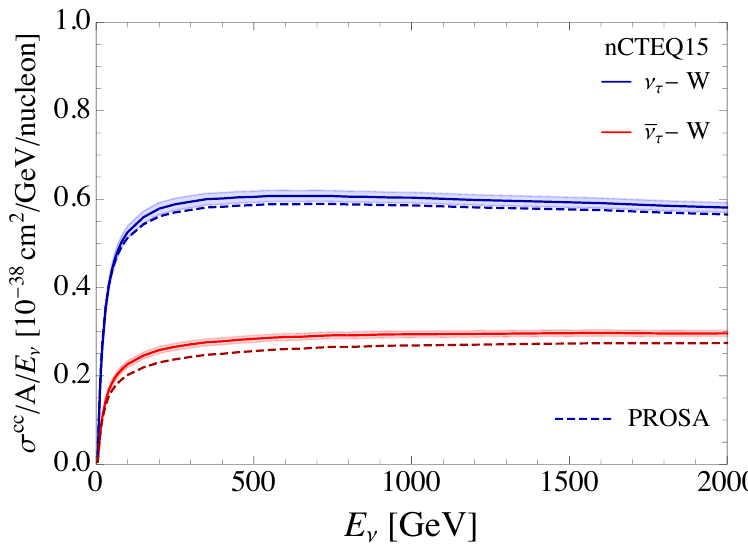
Figure 15. The charged current cross sections per nucleon for deep-inelastic scattering of tau neutrinos and antineutrinos on tungsten (W) for different PDF sets: nCTEQ15-W (i.e. nCTEQ15 for tungsten) and PROSA (VFNS). For the latter, we assume isospin symmetry in order to build neutron PDFs. The predictions are scaled by (anti-)neutrino energy and the bands reflects uncer- tainty due to the 32 sets of